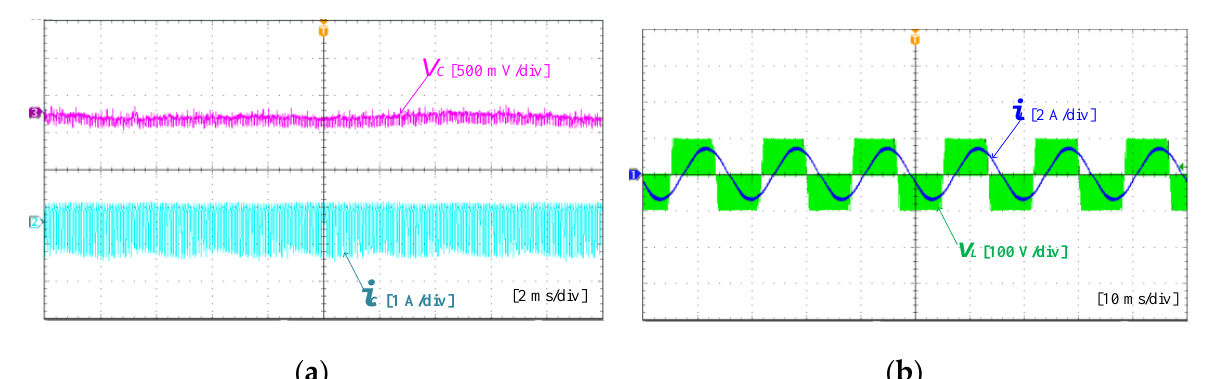
Table 2. Capacitor Parameters.